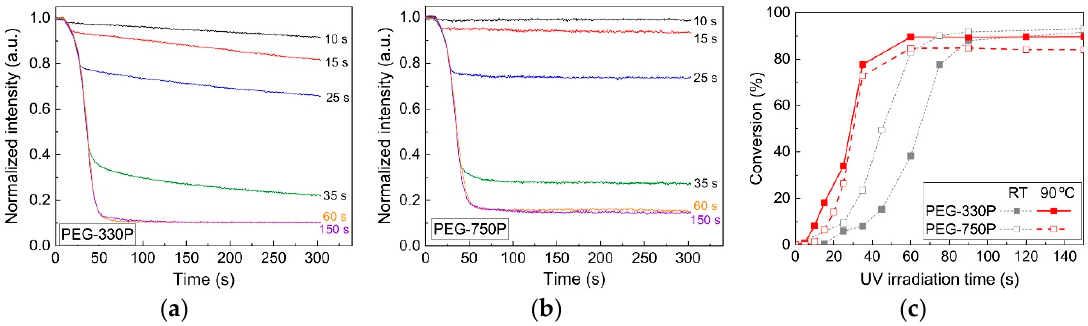
Figure 6. Transient intensity changes of ( a ) PEG-330P and ( b ) PEG-750P mixtures during UV curing under different irradiation times at 90 °C. ( c ) Changes in conversion value for the two hydrogel mixtures.